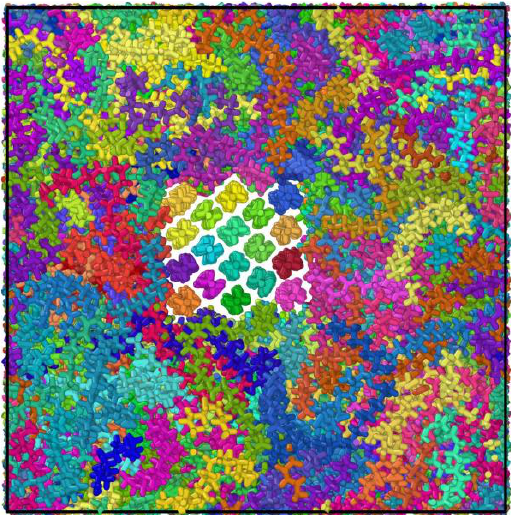
Figure 4. Molecular dynamics modeling of the mixture polyethylene structures.